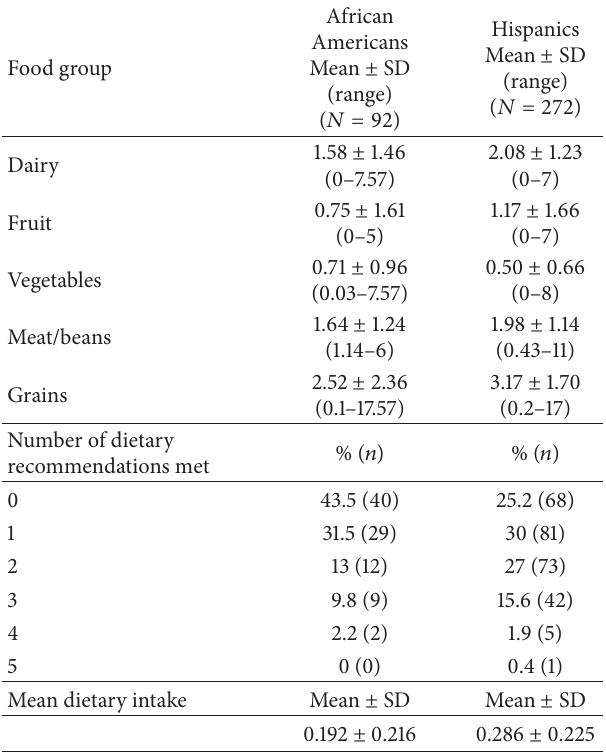
Table 5: Dietary intake of food groups among African American and Hispanic